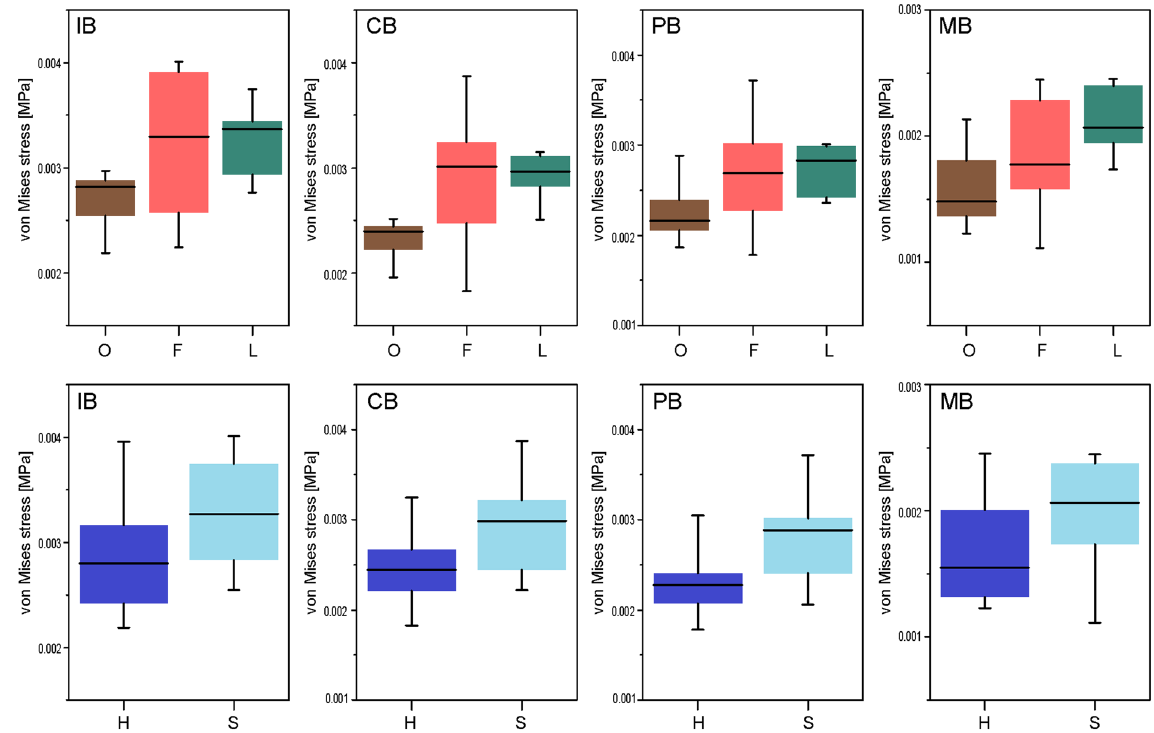
Figure 4. Box-plots of the MWM values of all species grouped by hardness of ingesta (H: hard eaters; S: soft eaters) and by dietary categories (O: omnivore; F: frugivore and L: folivore). IB: incisive bite; CB: canine bite; PB: premolar bite and MB: molar bite. The median is the middle line of the box and whiskers represent the